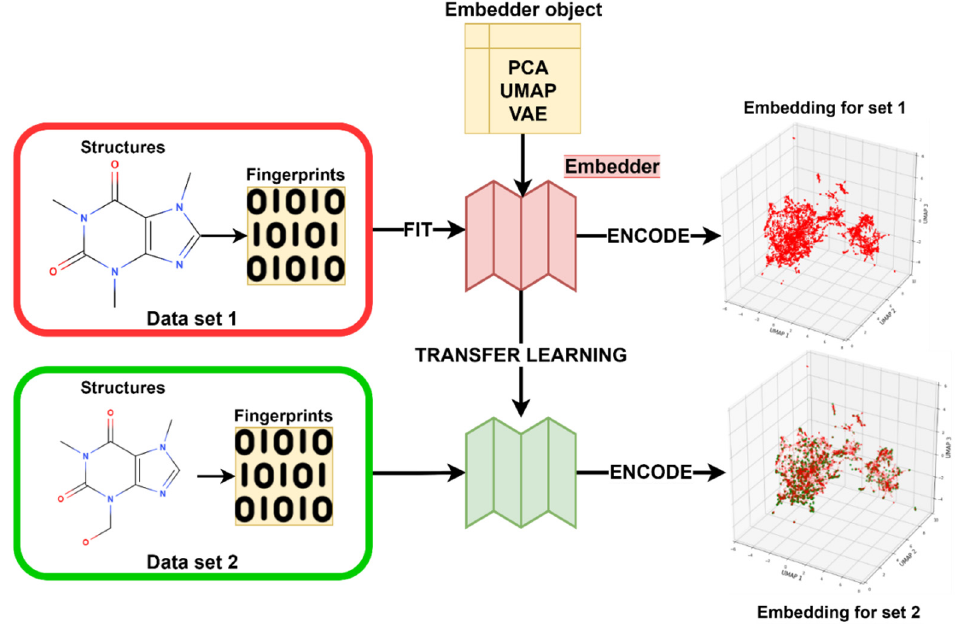
Figure 11. Schematics of chemical space transformation from fingerprint through a pre-trained embedder model. The transformation can either be conducted from an external data set to the data set of interest or within the data set of interest, but split into the train and test set.